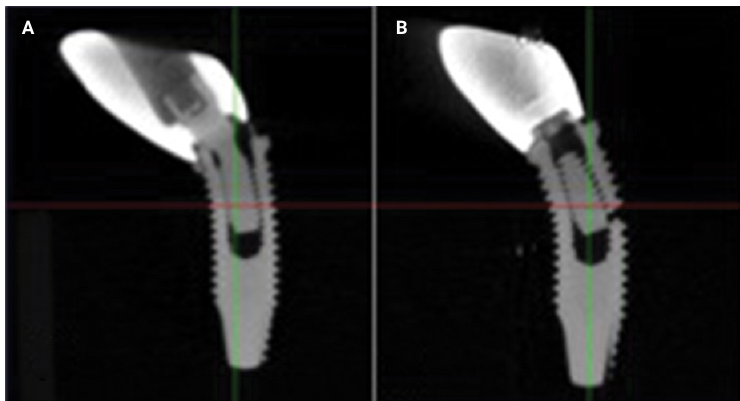
Figure 1. Micro-CT images representing the failure mode: (A) plastic deformation, and (B) plastic deformation and